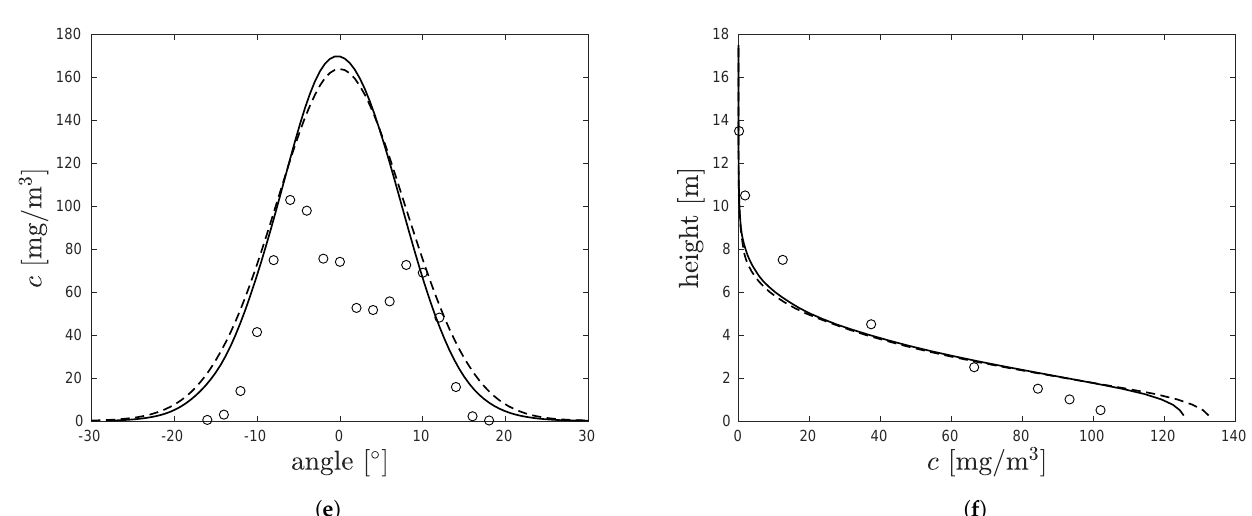
Figure 3. Measured ( ◦ ) and predicted concentration profiles by the PI (–) and KS (– –) estimator during a stable stratification at the 100m-arc for ( a , b ) experiment 22 ( c , d ) experiment 29 ( e , f ) experiment 40 with n p = 1000 particles per release time and ∆ t ∗ = 0.05. For each experiment the vertical profile from the tower closest to the wind direction is